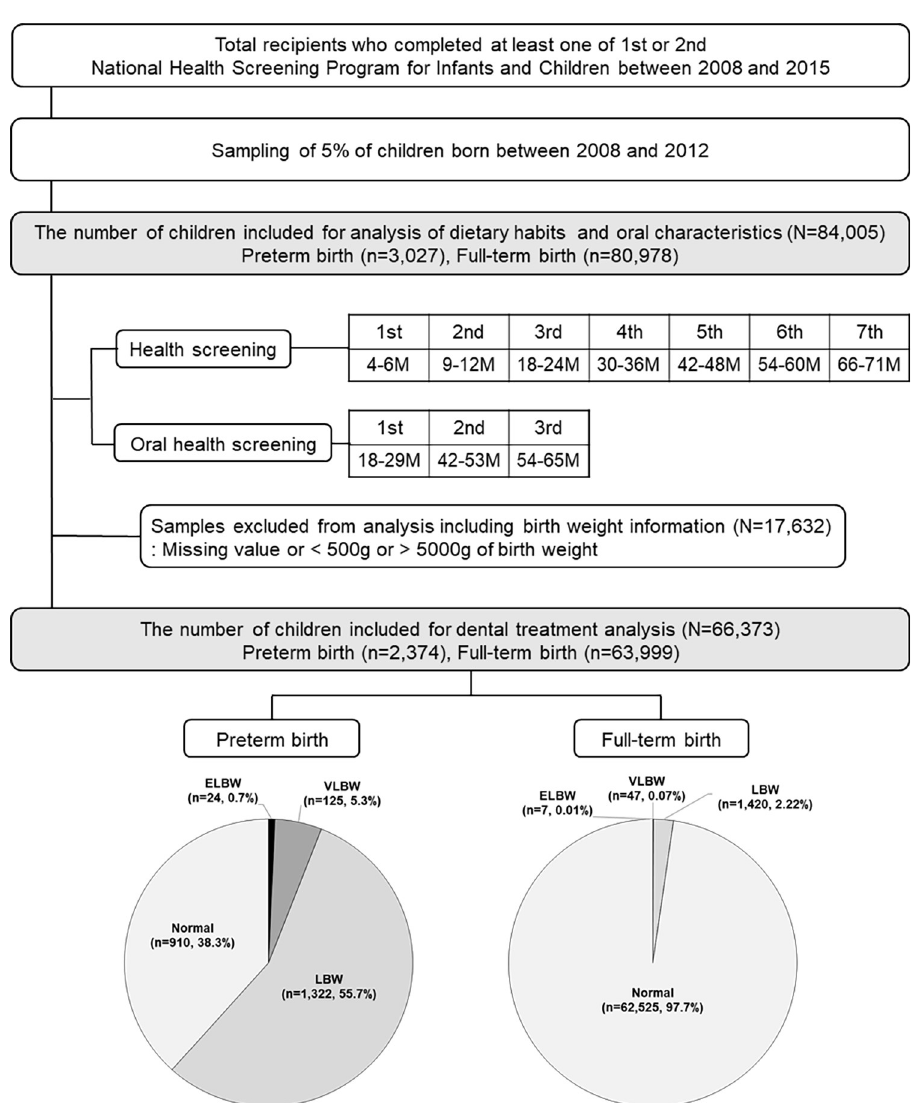
Fig 1. Flow diagram of participant selection. The proportion of preterm born infants were 3.6% (n = 2,374) of the study population. 38.3% of preterm children had normal birth weight, and 97.7% of the full-term children had normal birth weight ( � 2500 g). LBW: low birth weight ( � 1500 g and < 2500 g), VLBW: very low birth weight ( � 1000 g and < 1500 g), ELBW: extremely low birth weight ( � 500 g and < 1000